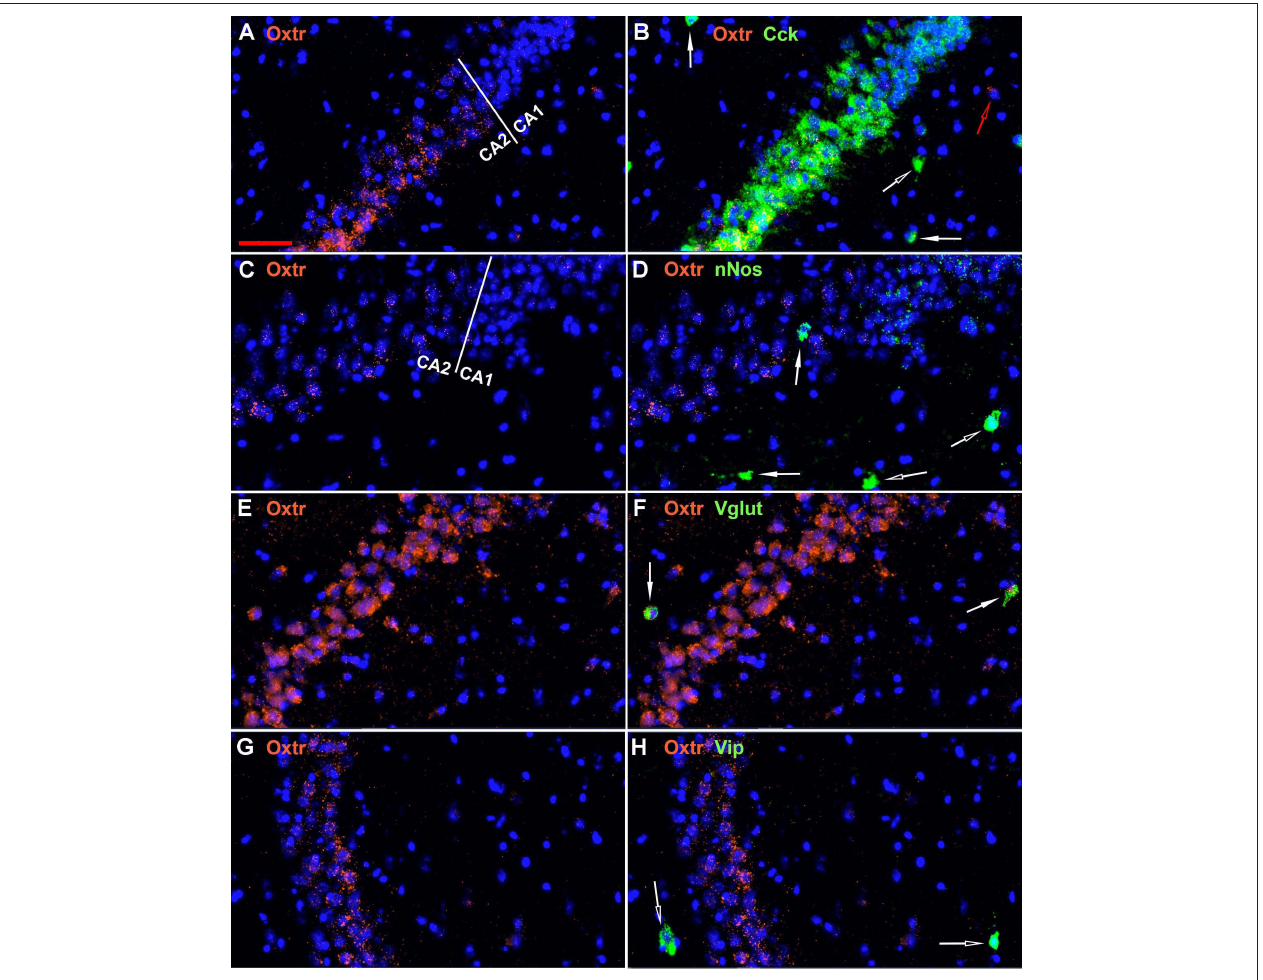
FIGURE 7 | Examples of the distribution of Oxtr within the CA2 hippocampal region. (A) shows Oxtr expression in the CA2 and (B) shows its colocalization with Cck transcripts. Cck expression also occurs in pyramidal neurons but less in the CA1 neurons. (C) shows Oxtr expression in the CA2 and (D) shows co-expression with nNos transcripts. In contrast to Cck, nNos expression is not apparent in the CA2 but is present in the CA1 pyramidal neurons. (E) shows Oxtr expression in the CA2 and (F) shows its colocalization with Vglut3 (Vglut) transcripts. (G) shows Oxtr expression in the CA2 and (H) shows its expression with Vip transcripts. Bar in (A) is 50 µ m and applies to all panels. Solid white arrows indicate colocalization of Oxtr transcripts with the INM transcripts. Open white arrows indicate only expression of the INM. Open red arrow indicates only expression of Oxtr.